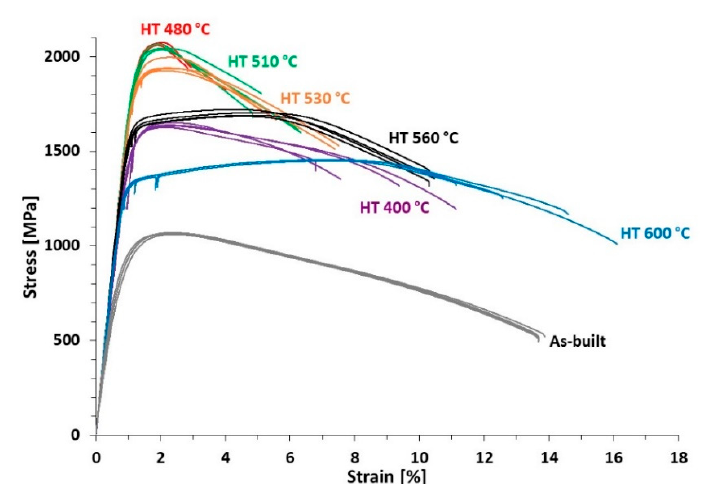
Figure 8. Tensile curves of maraging 300 (EN 1.2709) samples manufactured by SLM in LORTEK (as-built and direct aged with different temperatures for 6 h) [27].